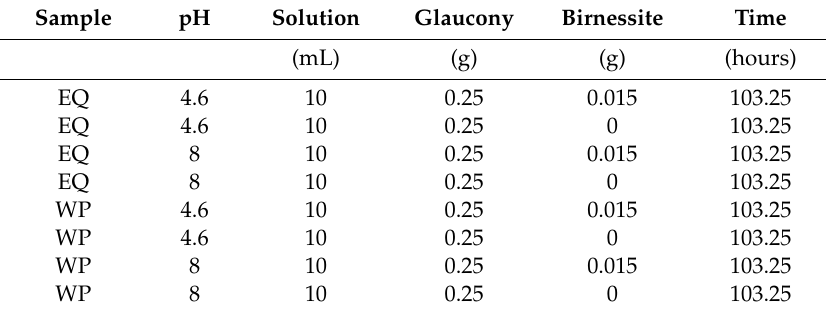
Table 2. Experimental parameters for glaucony solubility analysis with and without birnessite at pHs 4.6 and